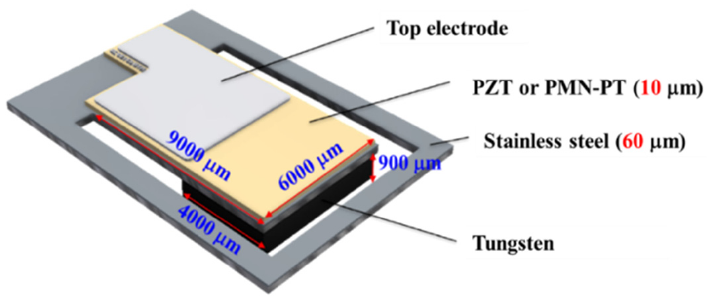
Figure 1. Illustration of the PMN–PT- or PZT-based micro-energy harvester with the geometric pa- rameters.